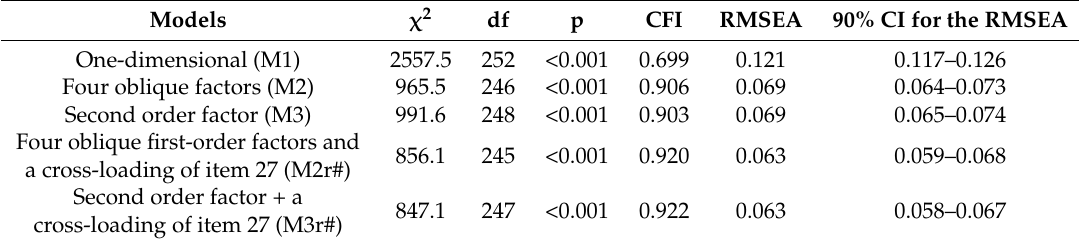
Table 3. Goodness-of-fit indexes for the confirmatory factor analysis (CFA)